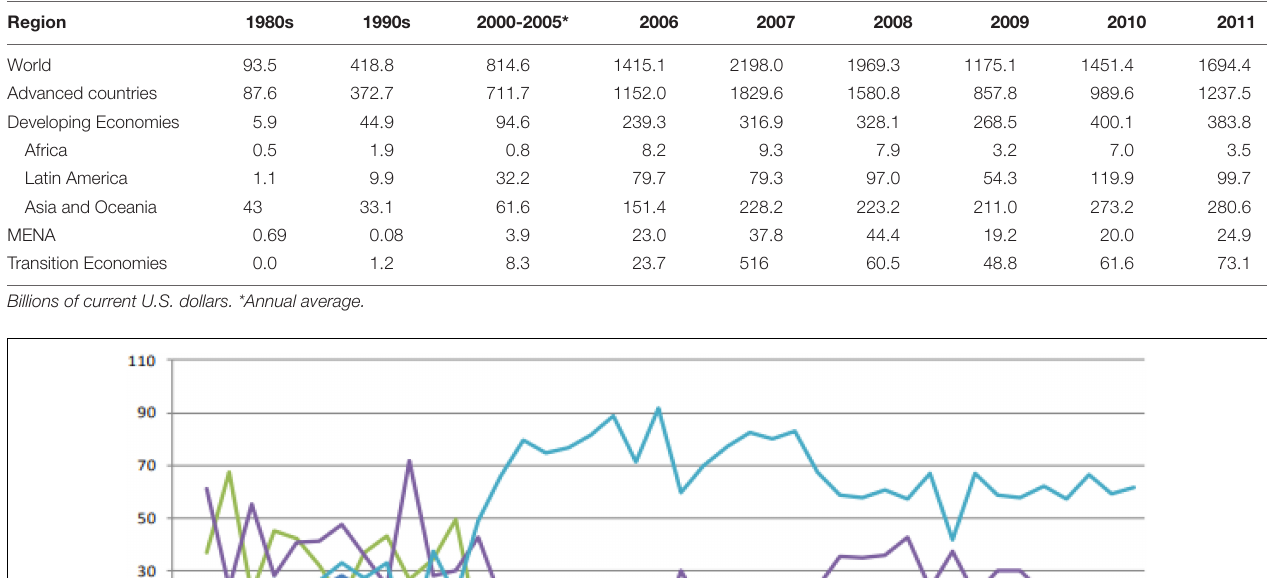
TABLE 1 | Outward FDI by Region: 1980–2011.